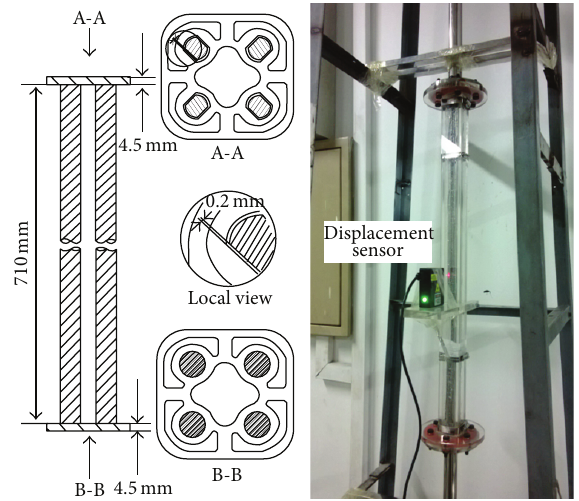
Figure5: Thecollocation and geometry ofthefuel assemblyand test section.